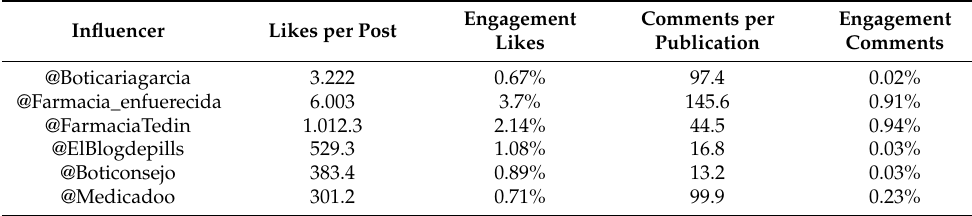
Table 2. Calculating engagement in likes and comments per influencer.